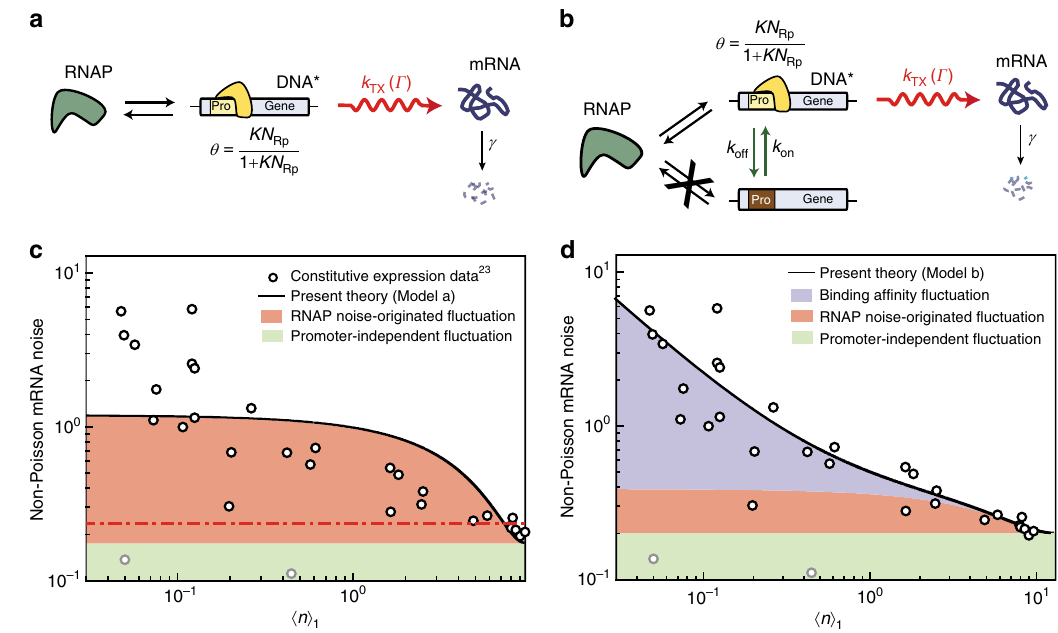
Fig. 4 Effects of RNAP-promoter binding af fi nity fl uctuation on non-Poisson mRNA noise in constitutive expression. a Transcription model of a constitutive (cid:2) (cid:3)(cid:6) (cid:7) gene without promoter strength fl uctuation. The overall transcription rate of a single-gene copy is modeled by R 1 ¼ KN Rp = 1 þ KN Rp k TX ð Γ Þ , where the number N Rp of RNAP is a stochastic variable, but the RNAP binding af fi nity K of the promoter is a constant. b Transcription model of constitutive gene with promoter strength fl uctuation due to conformational dynamics of DNA. The overall transcription rate is given by the same formula as transcription model a , but with K being a dichotomous stochastic variable whose value takes either 0 or K 0 . Our analysis shows fl uctuation in the value of K 0 is negligible (Supplementary Note 20). c (circles) Experimental results for the mean number h n i of mRNA per gene copy and non-Poisson noise Q n = n h i g h i Q n = n h ið Þ 1 1 ¼ from the constitutive expression data reported in Fig. 2 of ref. 23 . (red dot-dash) Prediction of the previous model proposed in ref. 23 . (solid line) Result of transcription model a best fi tted to the experimental data. d (solid line) Result of transcription model b best fi tted to the experimental data. Binding af fi nity fl uctuation in the constitutive expression occurs much faster than in the repressor-regulated gene expression (Supplementary Figs. 2 and 10). For constitutive gene expression, transcription model b provides a better quantitative explanation of the experimental data than Model III. However, in the absence of fl uctuation in N Rp , transcription model b becomes equivalent to Model III (Supplementary Fig.